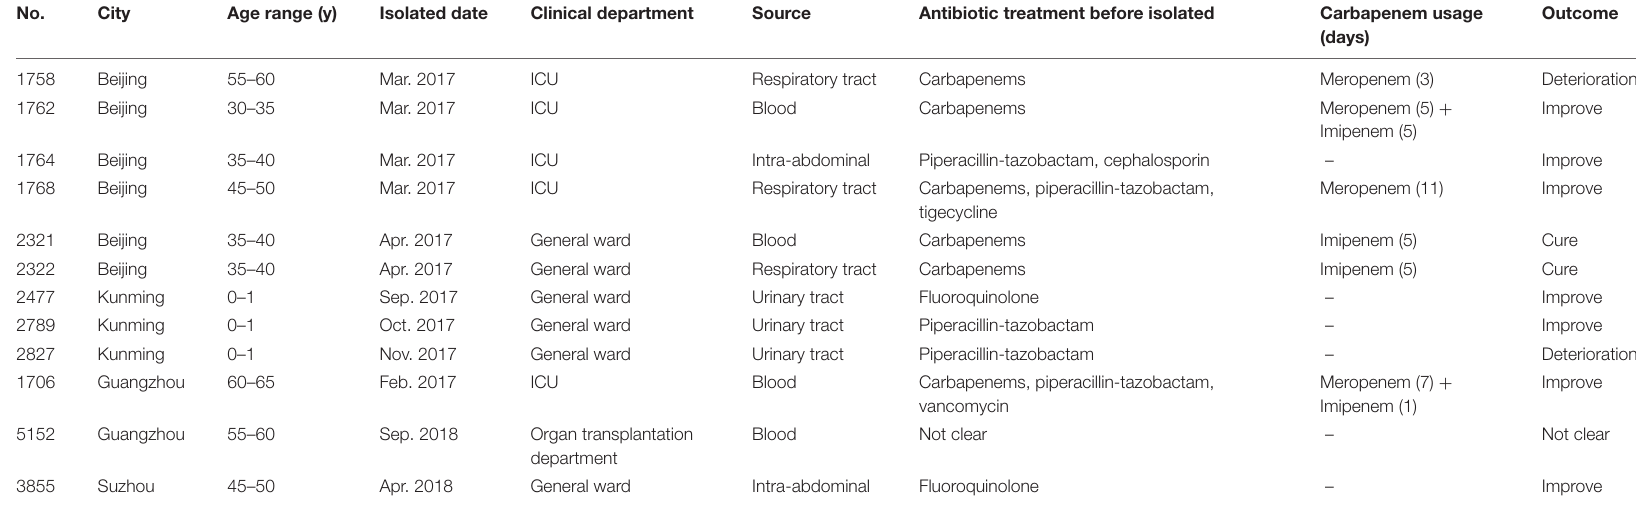
TABLE 3 | Clinical information of the 12 patients connected with the isolates with reduced susceptibility to ceftazidime-avibactam. No.